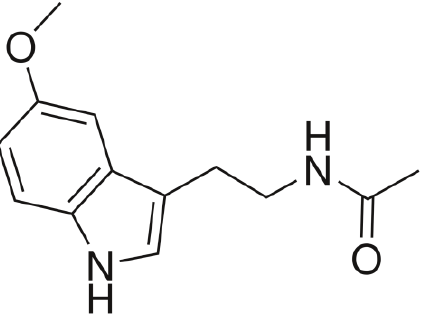
Figure 6. Chemical Structure of Melatonin (CAS: 73-31-4; Wikipedia, public domain) [255]. Originally all melatonin was derived from the pineal gland of cows, sheep, or